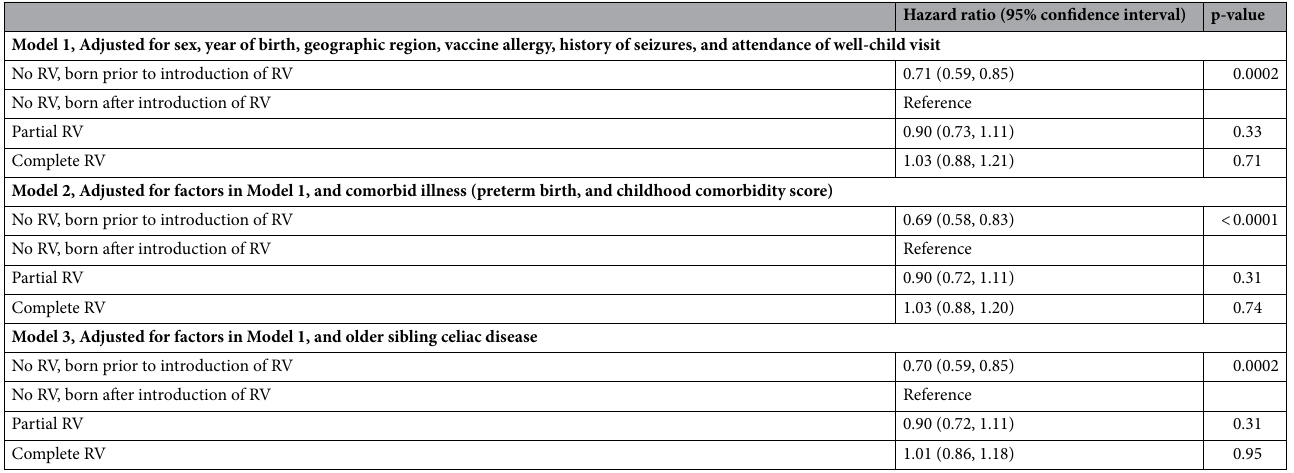
Table 2. Risk of celiac disease by rotavirus vaccination (RV)